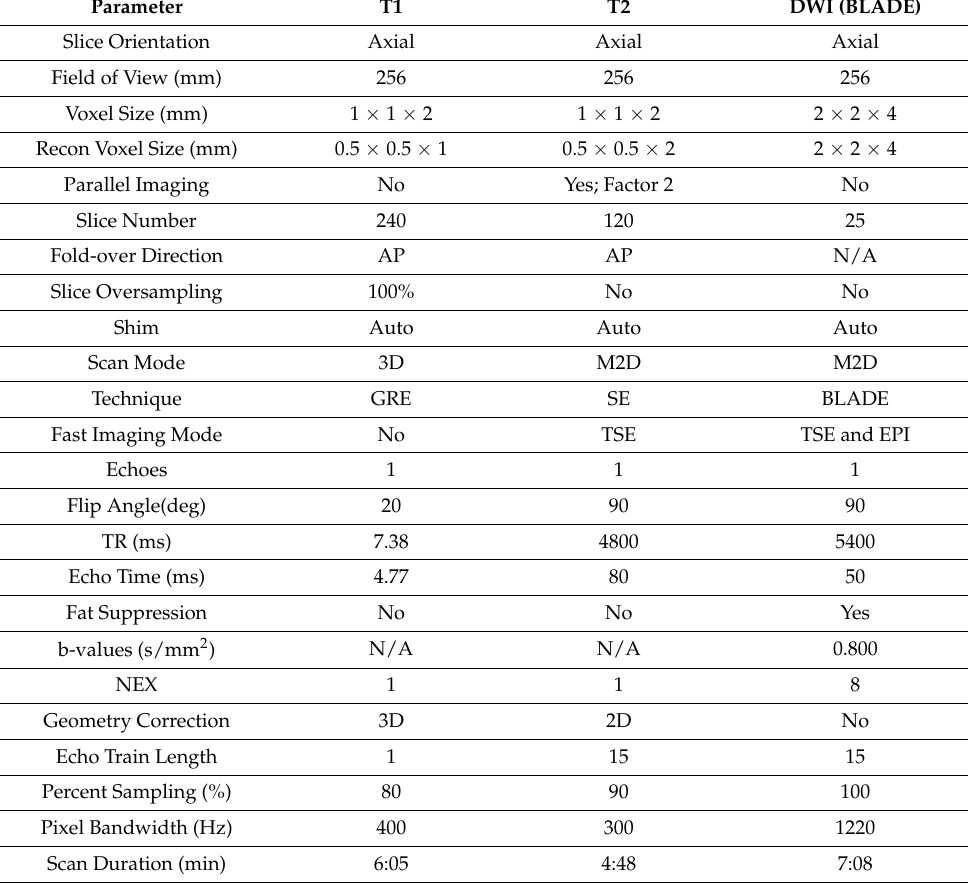
Table 1. MRI sequences and parameters obtained during the study